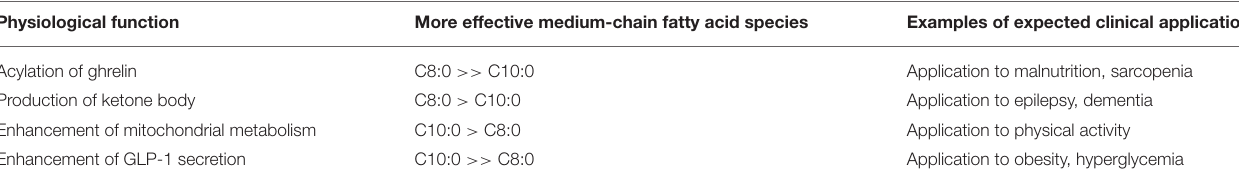
TABLE 5 | Differences in each physiological function by chain length of MCFAs. Physiological function More effective medium-chain fatty acid